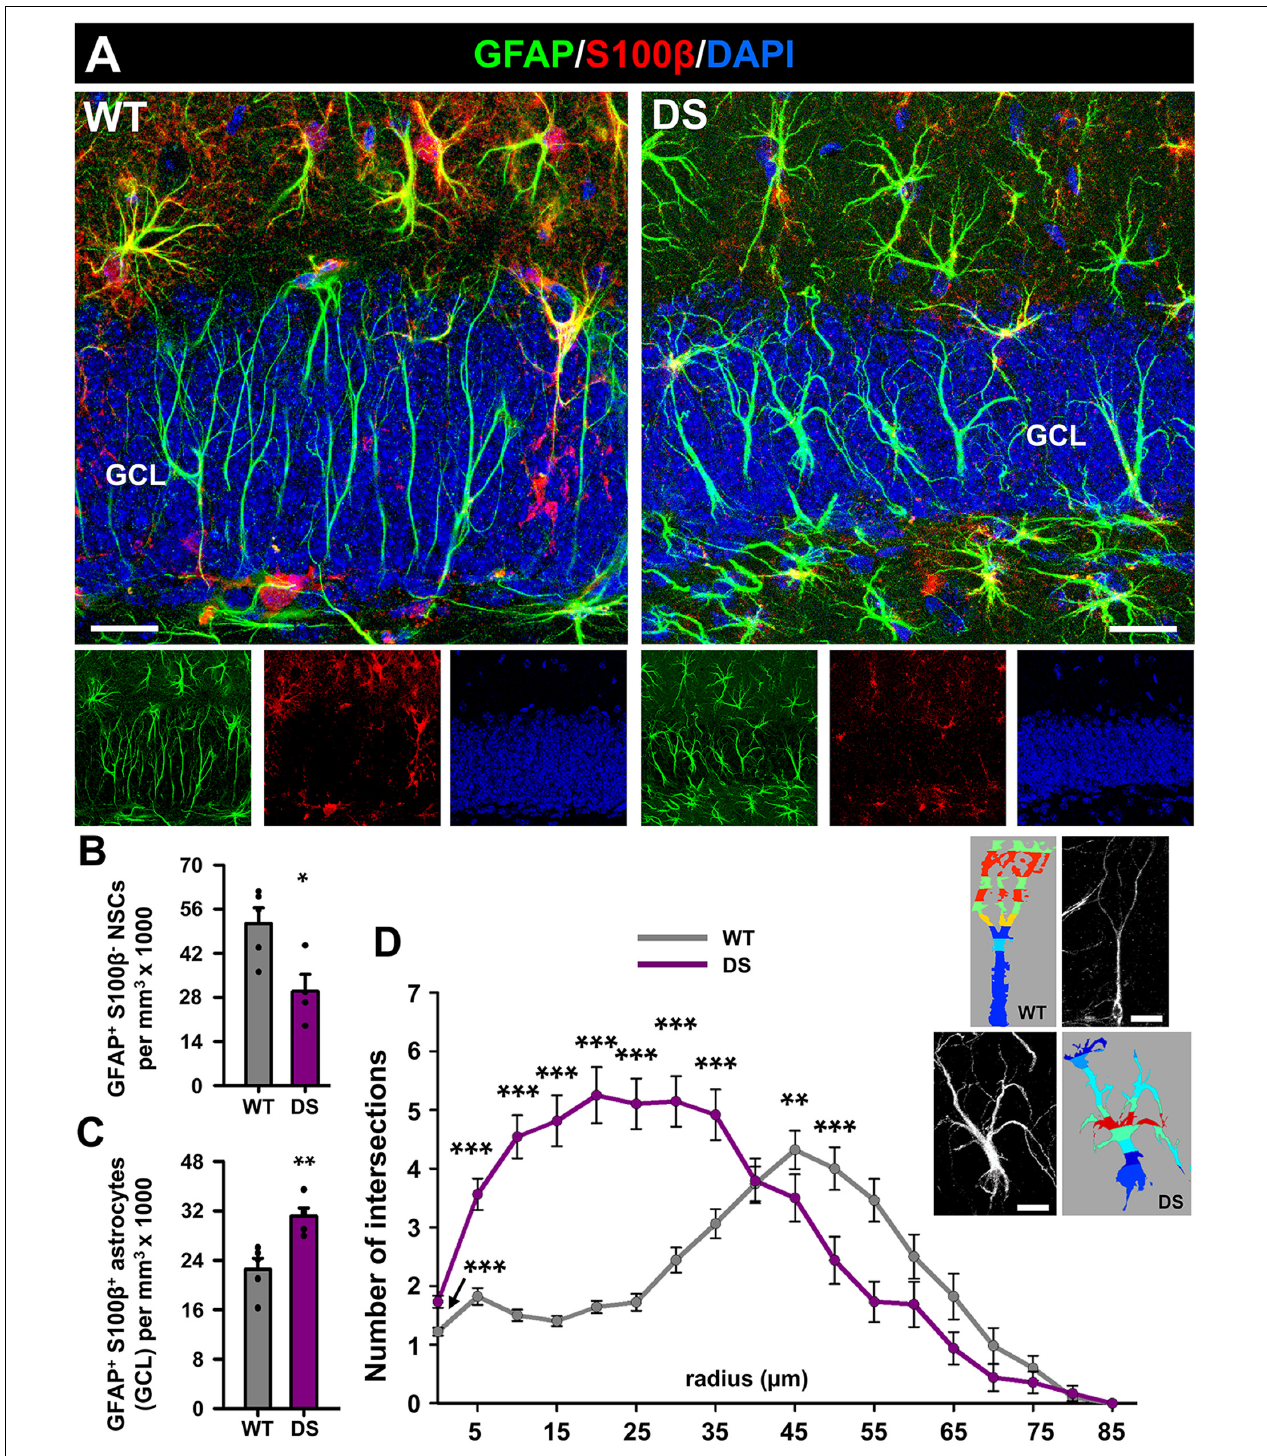
FIGURE 1 | Reactive morphology of NSCs in DS mice. (A) Representative confocal-microscopy images of the DG of WT (left) and DS (right) mice after staining for GFAP (NSCs and astrocytes) and S100 β (astrocytes). DAPI was used to stain cell nuclei. The number of NSCs is significantly decreased in DS mice (B) but the number of astrocytes is higher (C) . * p < 0.05, ** p < 0.01, by Student’s t -test (B,C) . The morphology of NSCs was studied by 3D-Sholl analysis using reconstructed cells derived from confocal microscopy z-stacks (insets) and showed an increase in the number of intersections in DS mice (D) ** p < 0.01, *** p < 0.001 by repeated-measures two-way ANOVA followed by Bonferroni post hoc test in. Bars show mean ± SEM. Dots show individual data. n = 5 for each condition. Scale bar in (A) is 20 µ m and 10 µ m in (B) .